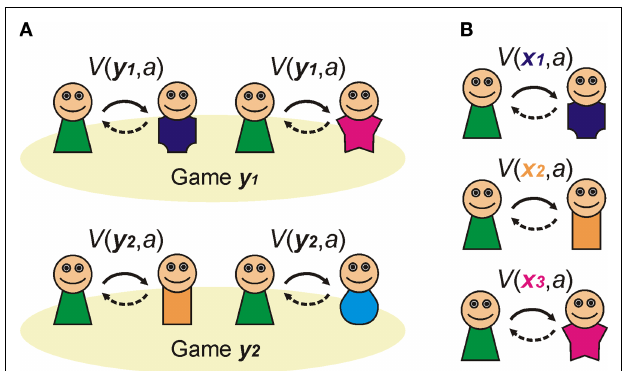
FIGURE 2 | Habitual learning of Prisoner’s dilemma. (A) Habit learning in specifi c games. An agent plays an action a when in a particular state that is defi ned by the game type, e.g. game y1. If the outcome is rewarded, then the action is reinforced, and is more likely to be emitted when the same state is encountered again. (B) Habit learning with specifi c opponents. An agent (in green) plays action a (cooperate) when interacting with a particular